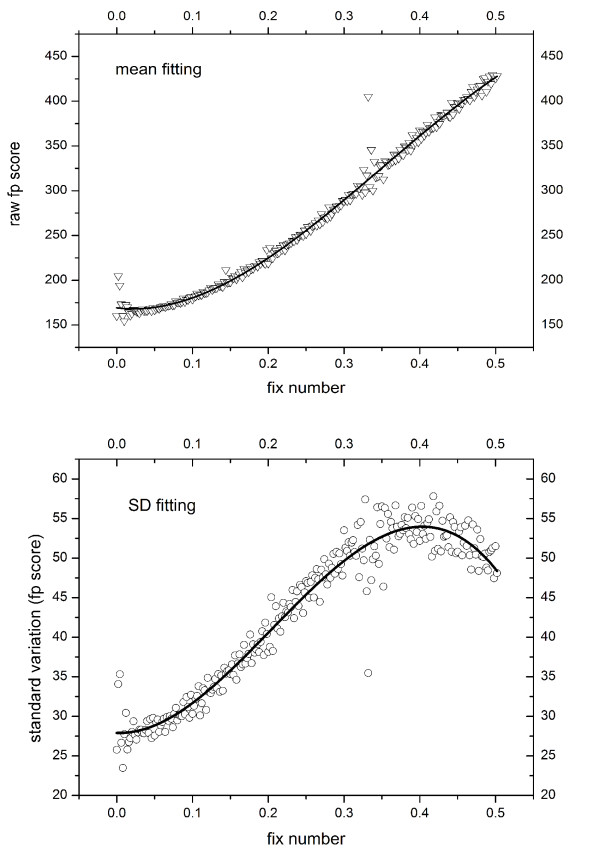
Least square fitting of the mean and standard deviation of the raw fingerprint scores.